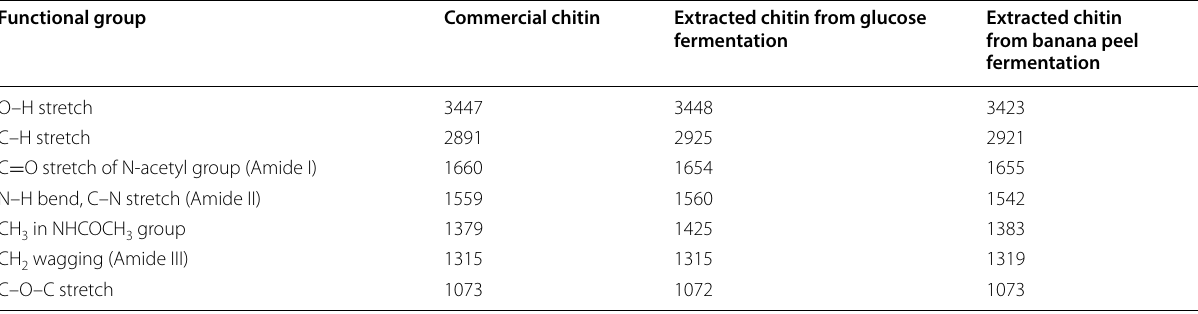
Table 3 FTIR bands (cm − 1 ) for commercial chitin, extracted chitin from glucose fermentation and from banana peel